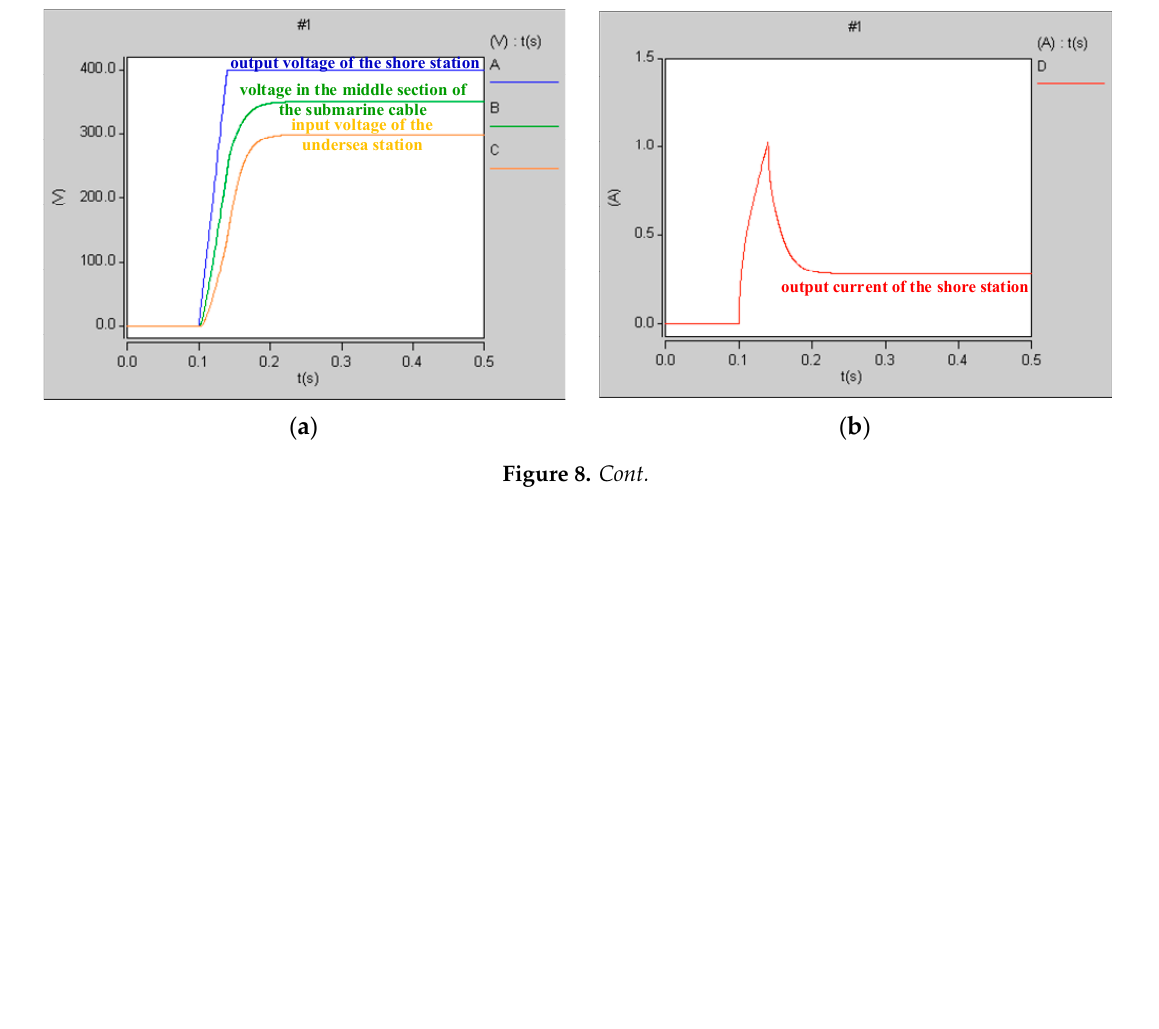
Figure 7. The Saber file for the large-signal stability simulation of a single-node CSO undersea DC power system. Table 4. Five Saber parameter sets for large-signal stability simulation of a single-node CSO undersea DC power system.